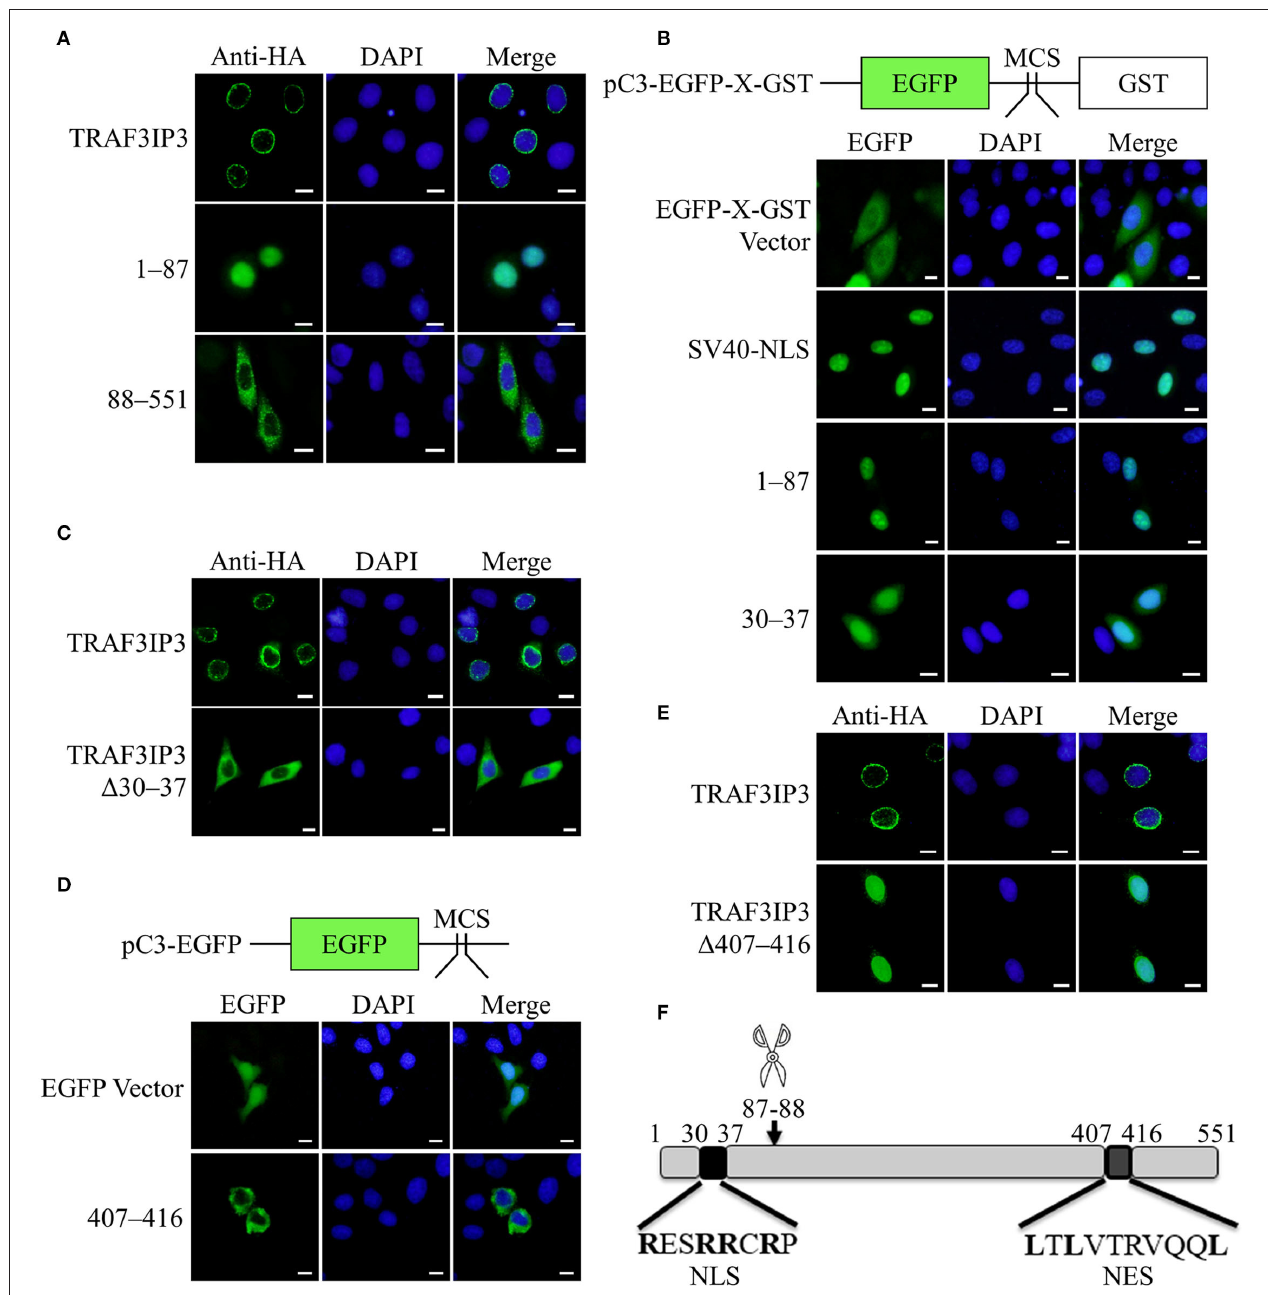
FIGURE 5 | Identification of the NLS and NES of TRAF3IP3. The subcellular localization of the protein was detected using immunofluorescence analysis. Cells were fixed 48h after transfection. Scale bars represent 10 µ m. (A) HeLa cells were transfected with HA-TRAF3IP3, HA-TRAF3IP3 1–87, or HA-TRAF3IP3 88–551. (B) Schematic representation of the pC3-EGFP-X-GST vector. HeLa cells were transfected with EGFP-X-GST vector, EGFP-SV40 NLS-GST, EGFP-TRAF3IP3 1–87-GST, or EGFP-TRAF3IP3 30–37-GST. (C) HeLa cells were transfected with HA-TRAF3IP3 or HA-TRAF3IP3 1 30–37. (D) Schematic representation of the pC3-EGFP vector. HeLa cells were transfected with EGFP vector or EGFP-TRAF3IP3 407–416. (E) HeLa cells were transfected with HA-TRAF3IP3 or HA-TRAF3IP3 1 407–416. (F) Schematic representation of the NLS and NES of TRAF3IP3.